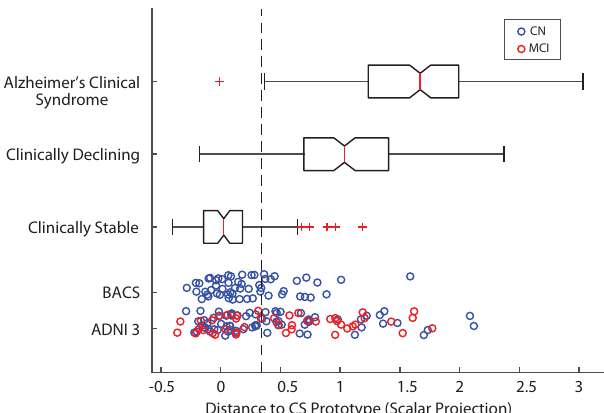
Fig. 3 Distribution of the scalar projection for the ADNI2/GO, ADNI3 and BACS samples. The distribution of the scalar projection for individuals from ADNI2/GO in the Clinically Stable ( n = 100), Clinically Declining ( n = 156) and Alzheimer ’ s clinical syndrome ( n = 181) groups (APOE 4 positive: n = 116, APOE 4 negative n = 140), the red line is the median of the group, the solid black box represents the 25th to 75th percentile and the black horizontal lines represent the range of the data, red crosses are outliers from the distribution, non-overlapping notches indicate signi fi cantly different medians ( p < 0.05). Blue dots indicate individuals from ADNI3/ BACS who are cognitively normal (CN) at baseline. Red dots indicate individuals from ADNI3 who have Mild Cognitive Impairment (MCI) at baseline. The dashed vertical black line represents the probabilistic boundary used to classify Clinically Declining vs. Clinically Stable, all individuals to the right of the line are classi fi ed as Clinically Declining. Source data are provided as a Source Data fi